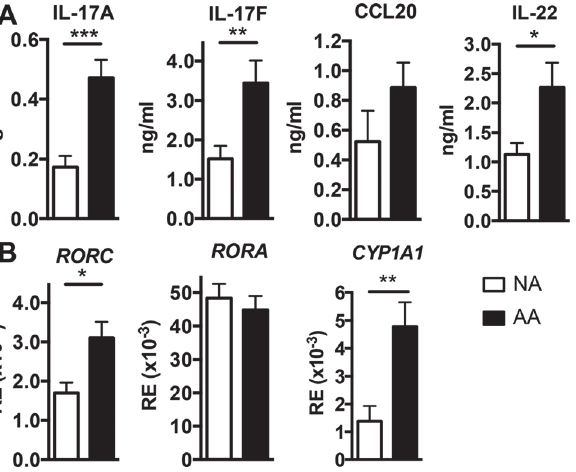
Fig 1. Th17/Th22 type profile of anti-CD3/CD28-activated peripheral blood mononuclear cells. A Cytokine secretion by activated peripheral blood mononuclear cells from nonallergic (NA) subjects (n = 10) and allergic asthmatic (AA) patients (n = 12), was evaluated at 72hr by ELISA and expressed as mean ± SEM ng/ml. B Gene mRNA level in activated peripheral blood mononuclear cells from NA subjects (n = 8) and AA patients (n = 11), was evaluated at 72hr by Q-RT-PCR and expressed as mean relative expression (RE) of 2^ (- Δ Ct) ± SEM, where the Δ Ct value of the sample was determined by subtracting the Ct value of the target gene from the Ct value of the rs9 house keeping gene. * P < .05, ** P < .01, and *** P <